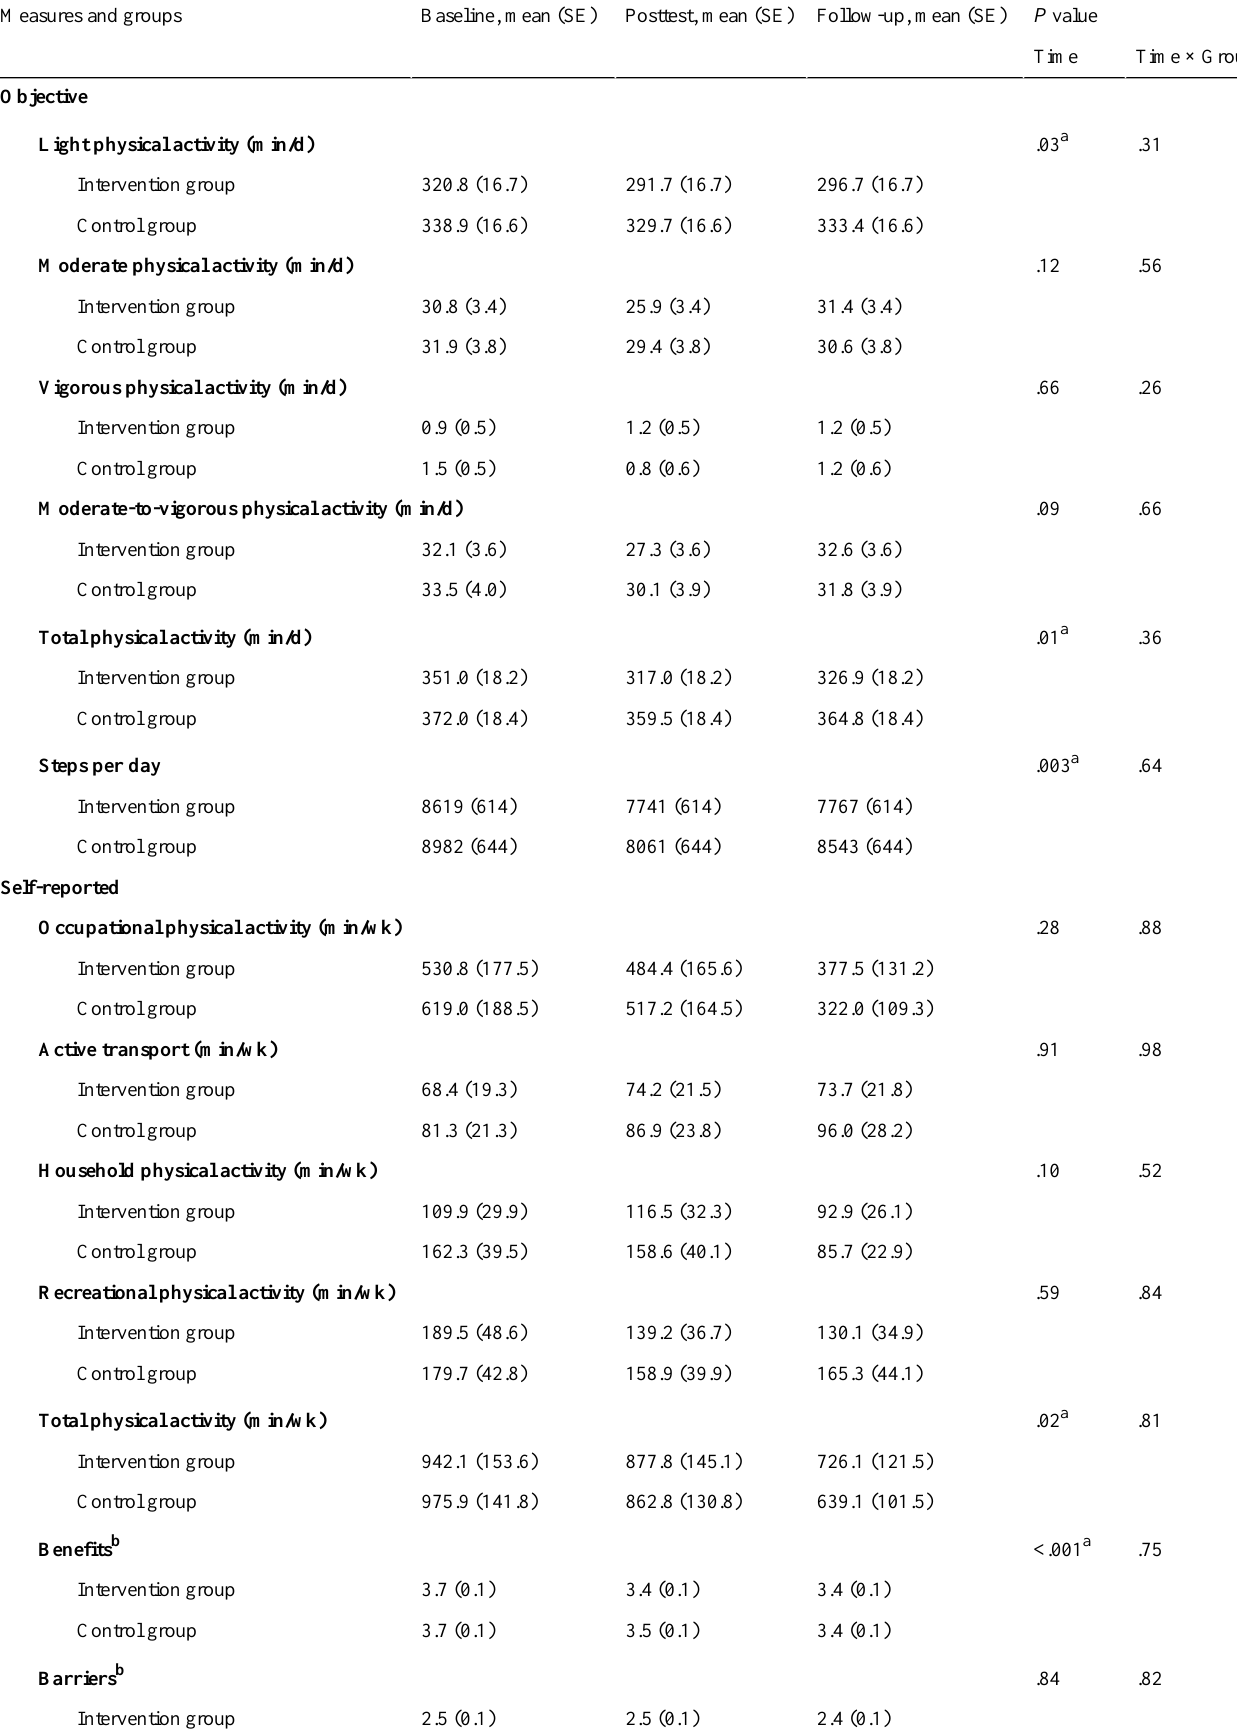
Table 3. Intervention and time effects of the objective physical activity, self-reported physical activity, and self-reported psychosocial variables.